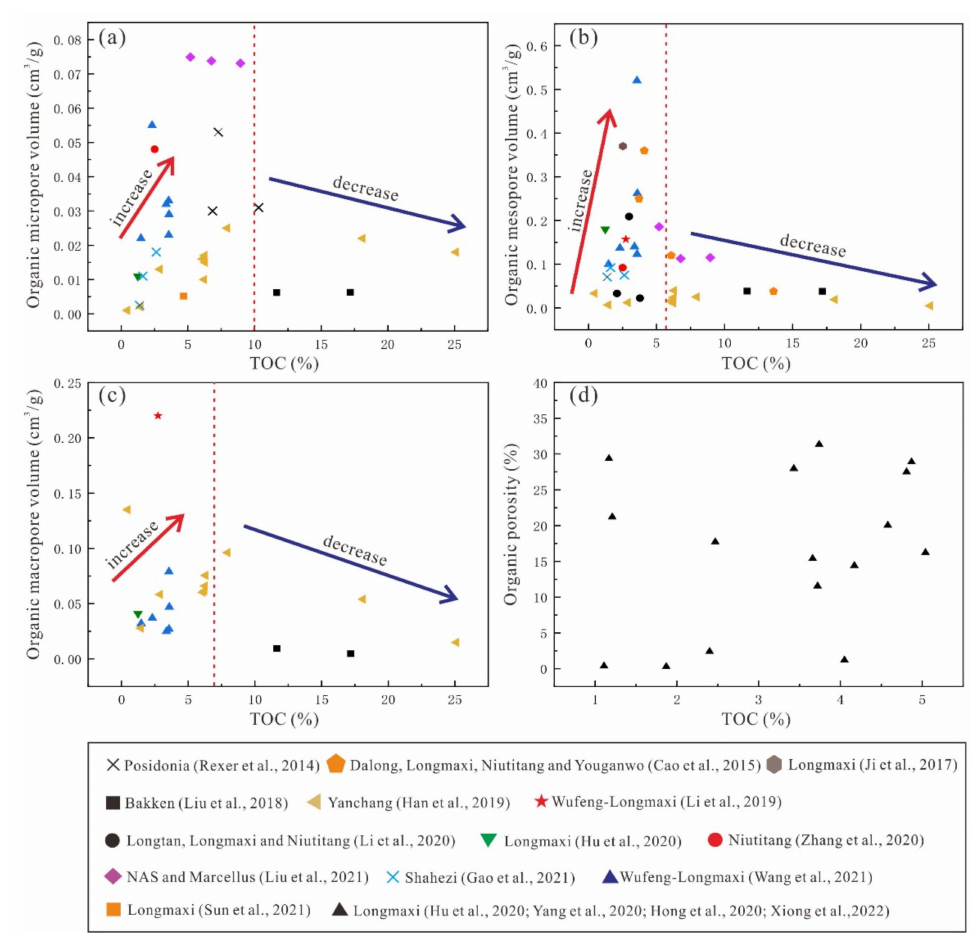
Figure 6. Cross-plots of TOC content versus ( a ) micropore volume, ( b ) mesopore volume, ( c ) macrop- ore volume, and ( d ) organic porosity of shale samples. Pore structure parameters were measured from the kerogen fraction of shale samples. Data are from